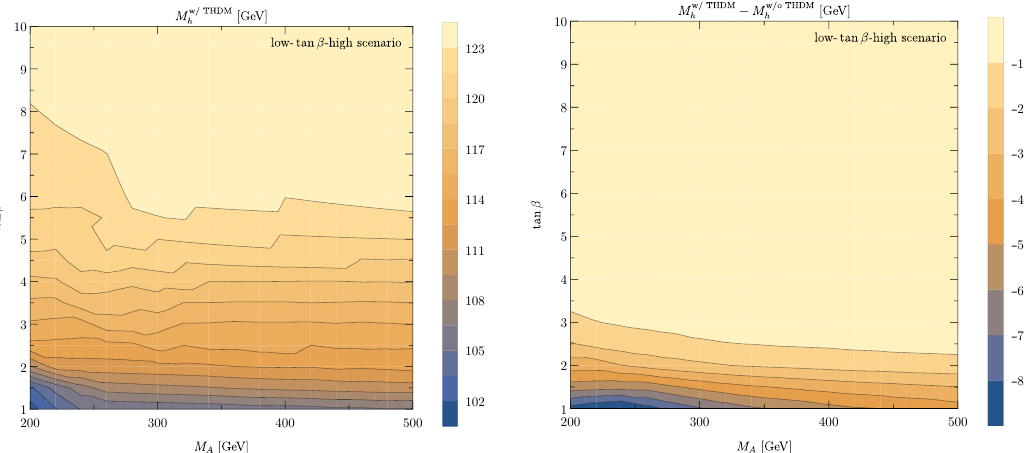
Figure 10 . Left: M h computed with FeynHiggs including the e(cid:11)ective THDM as a function of M A and tan (cid:12) in the low-tan (cid:12) -high scenario. Right: di(cid:11)erence between the results with and without e(cid:11)ective THDM ( FeynHiggs2.14.0